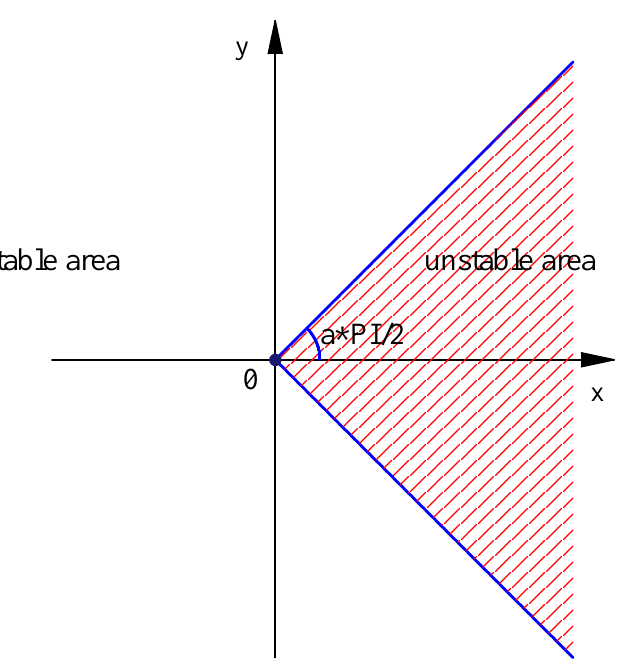
Figure 3. Stability domain and unstability domain of system